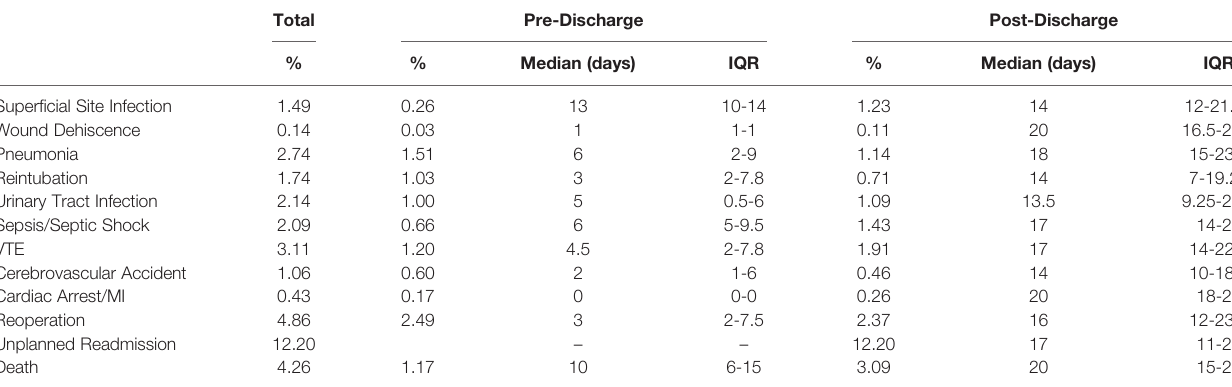
TABLE 2 | Prevalence of complications strati fi ed by index